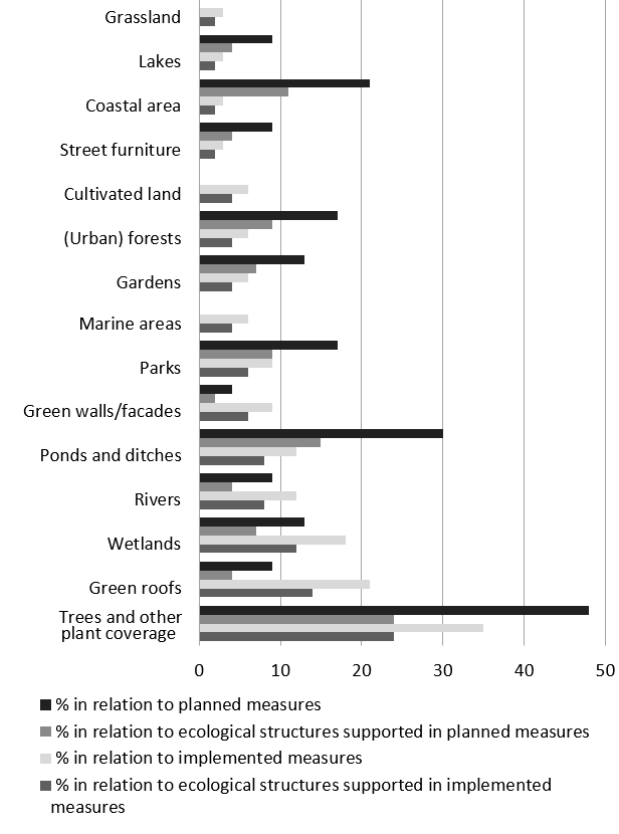
Fig. 6 . Risk-reducing approach of identified measures. Multiple categorizations of single measures are included.